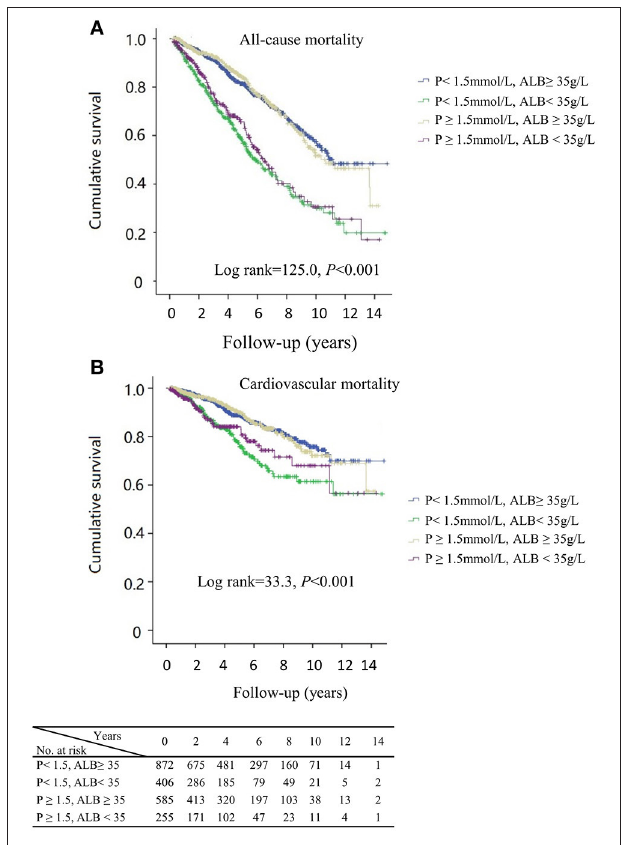
FIGURE 3 | Kaplan–Meier curves of all-cause (A) , cardiovascular mortality (B) by subgroups of phosphorus and albumin levels, respectively. P, phosphorus; ALB,